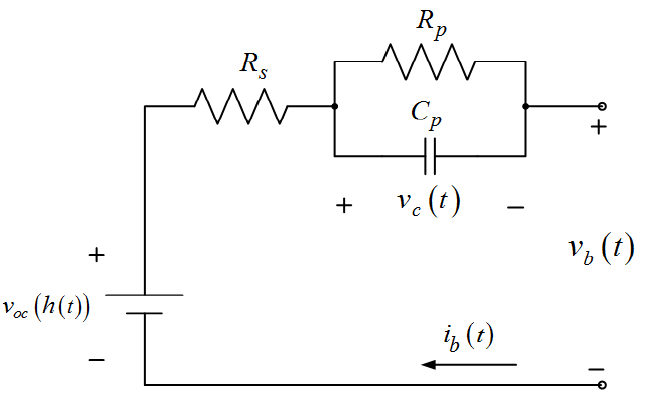
Figure 1. Equivalent circuit model of the lithium-ion